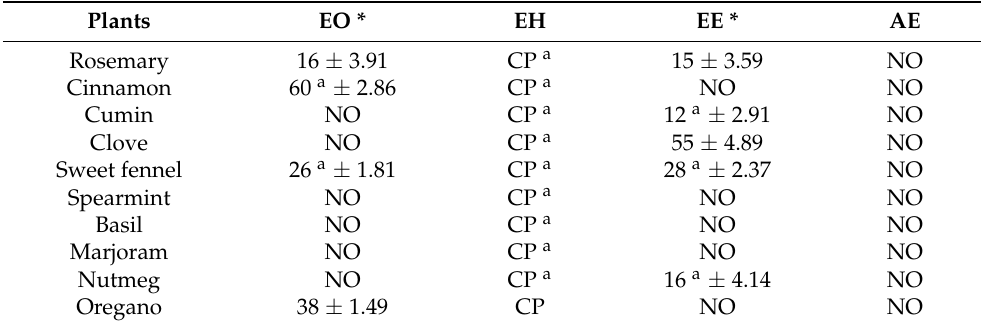
Table 1. The inhibitory effect of essential oils and extracts on Aspergillus westerdijkiae growth using the measurement of the diameter of inhibition zone in mm using the agar diffusion method.